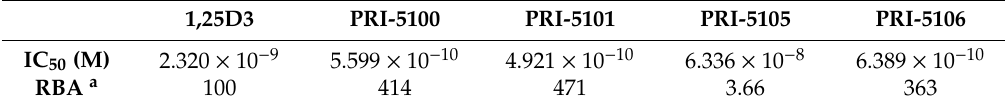
Table 2. Monocytic differentiation induced by 1,25D3 and analogs.